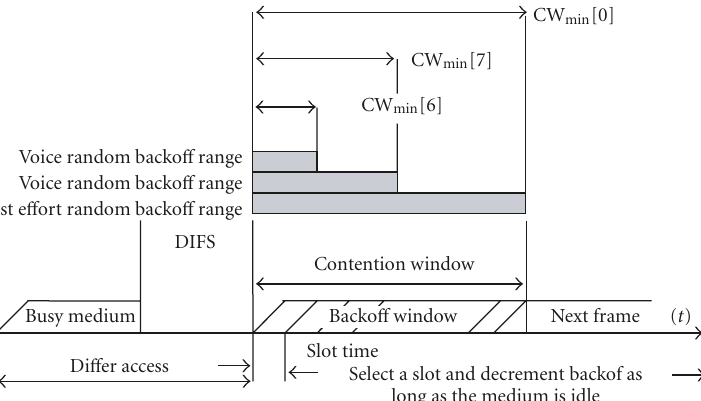
Figure 1: Old DCF and EDCA.